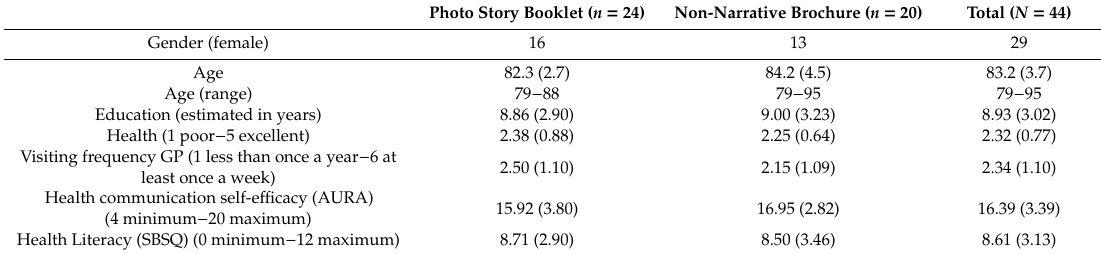
Table 4. Participant characteristics (means and standard deviations) in the interview study. Photo Story Booklet ( n =